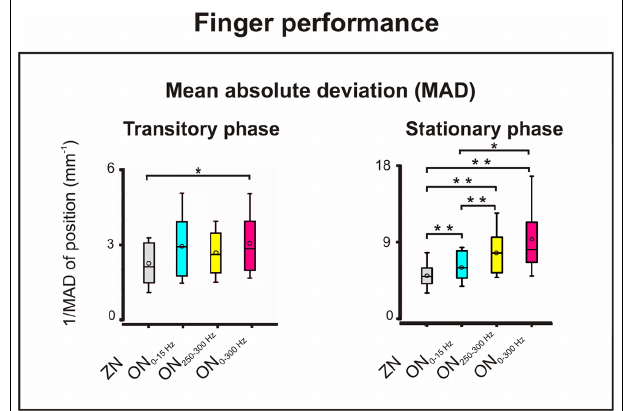
FIGURE 3 | Motor performance: mean absolute deviation (MAD) of the finger position for ZN and for ON for the three noise bandwidths during the transitory (left) and stationary (right) phases of the isometric compensation task. During the transitory phase, stochastic resonance (SR) effect with better performance only for ON 0 − 300 Hz (* p = 0.01). During the stationary phase, SR effect for the three frequency bandwidths with best performance for ON 250 − 300 Hz and ON 0 − 300 Hz . * p = 0.006; ** p =